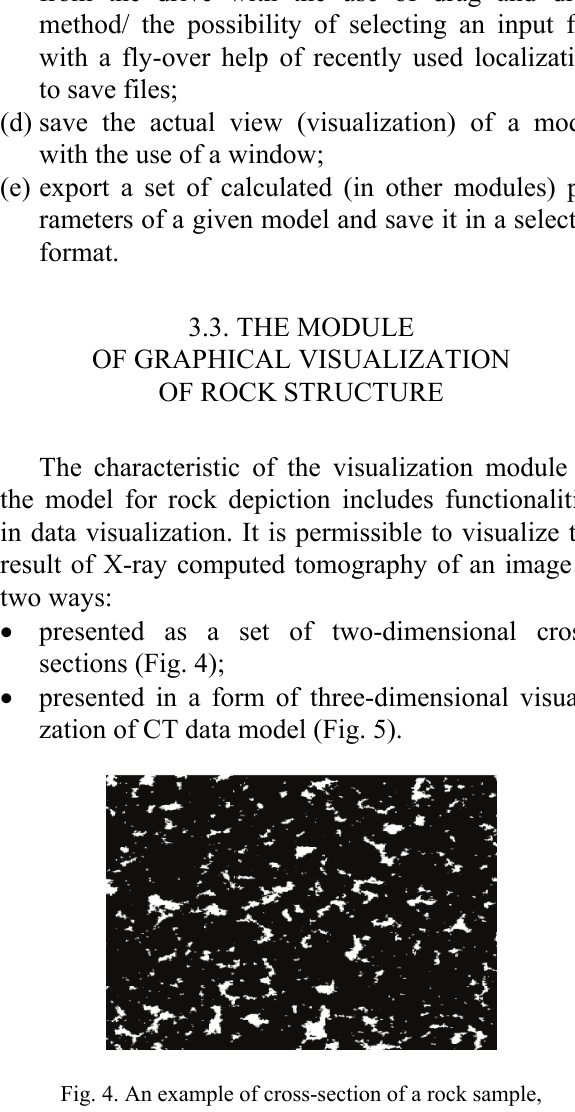
Fig. 4. An example of cross-section of a rock sample, binarized in order to detect pore space (claystone) in the new computer system